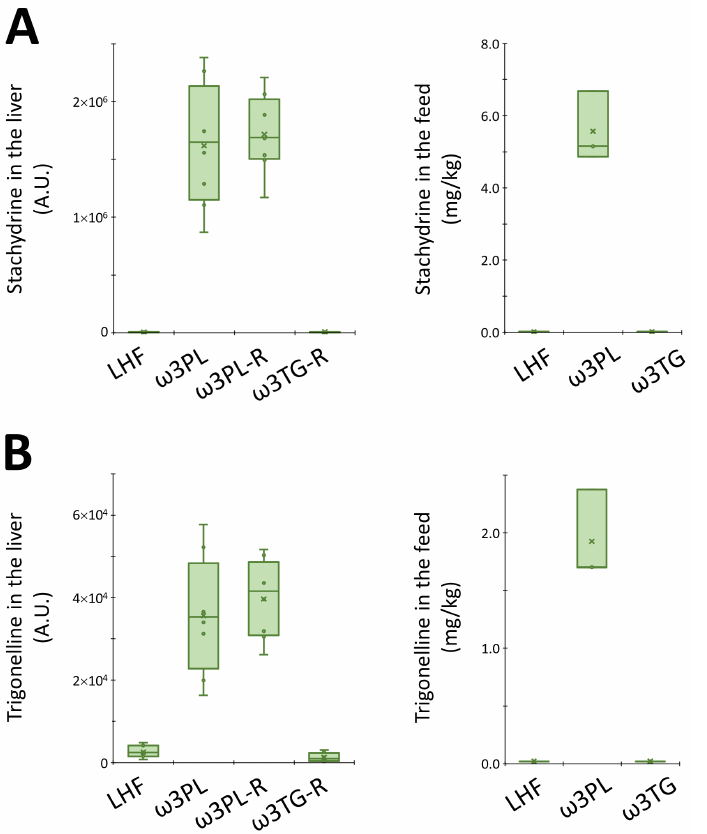
Figure 8. Box plots for stachydrine ( A ) and trigonelline ( B ) levels in the liver (arbitrary units; left panel) and in experimental diets (mg/kg; right